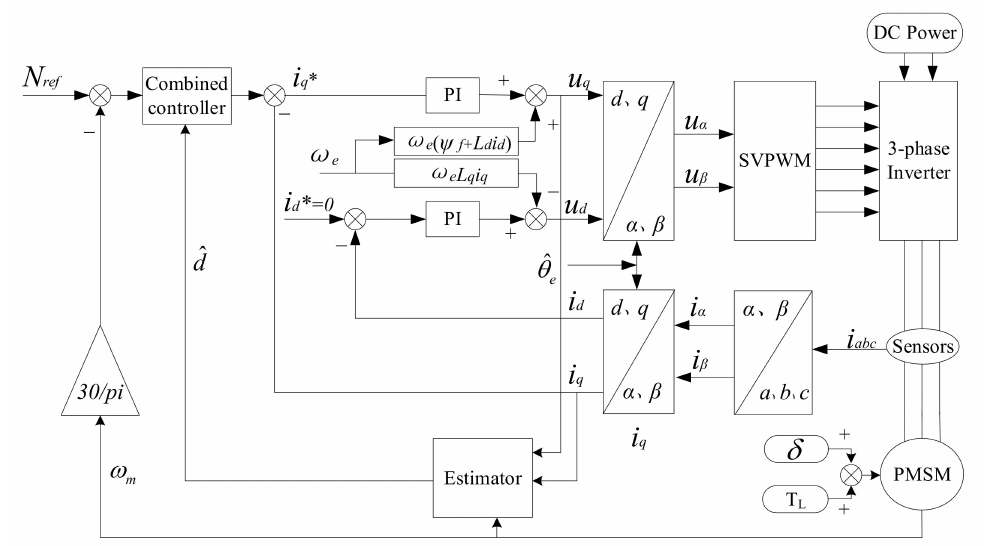
Figure 2. The speed control and estimator blocks.